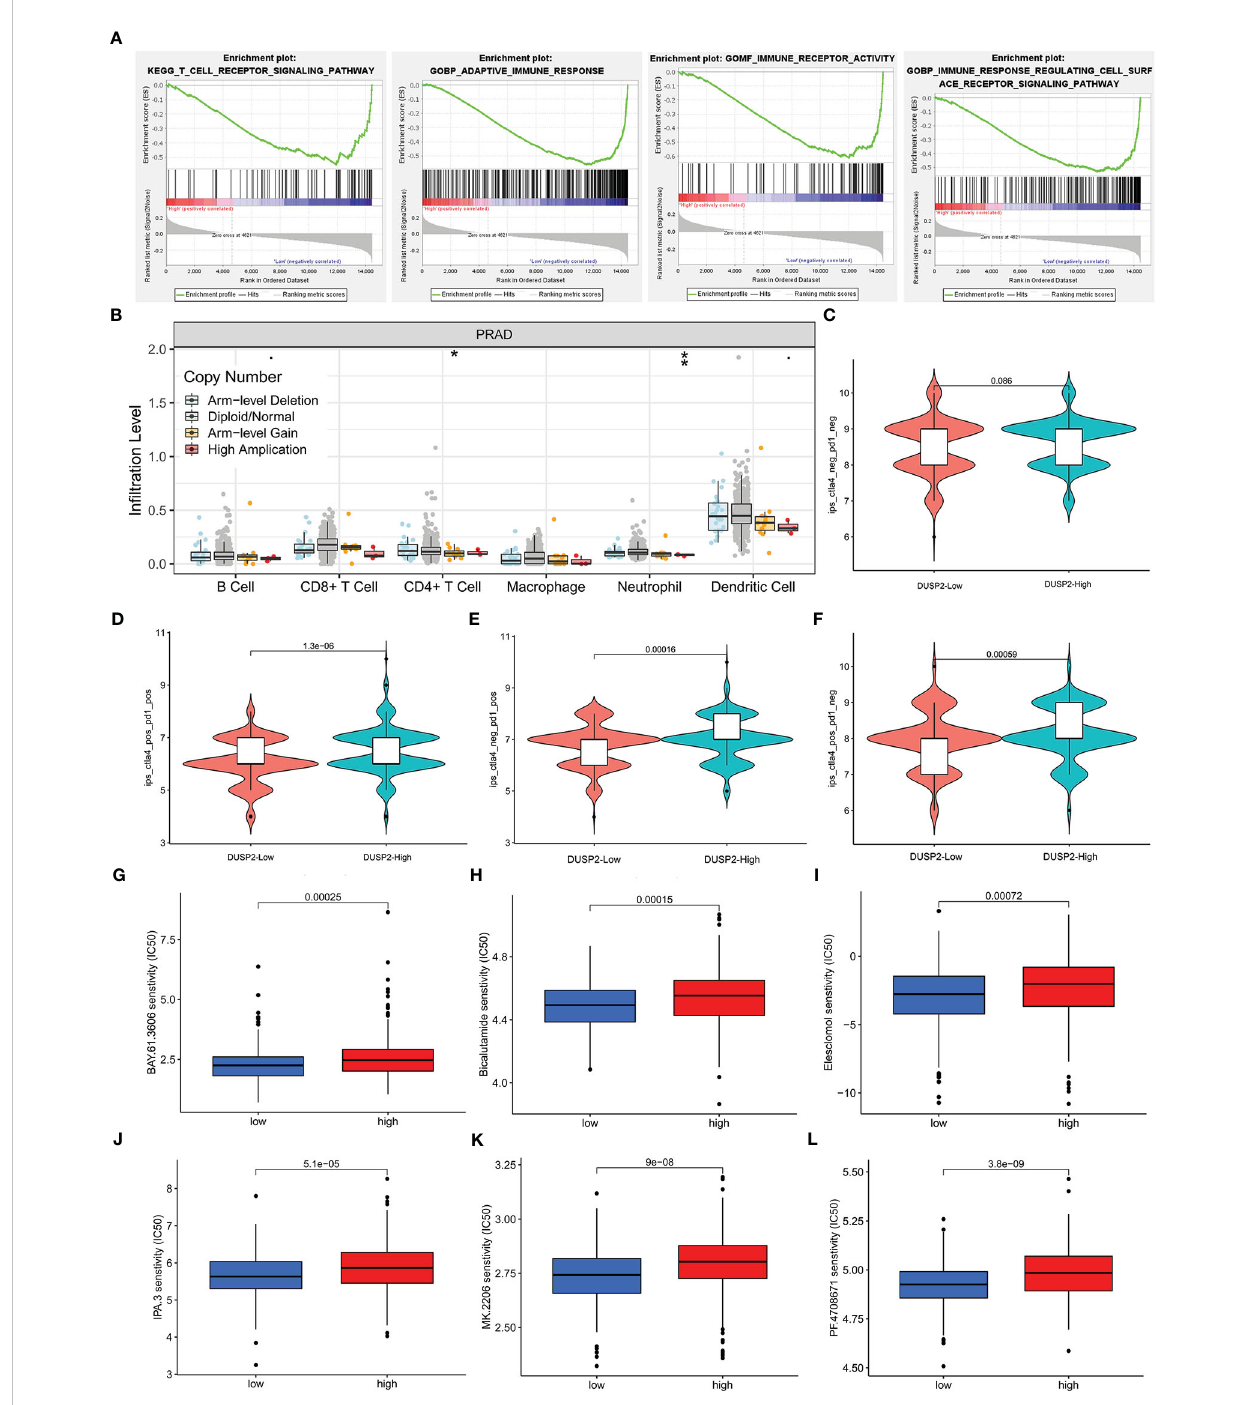
FIGURE 7 Immune in fi ltrate levels as well as immunotherapy or chemosensitivity analysis of DUSP2. (A) GSEA for DUSP2 with GSE60329. (B) Correlation of DUSP2 expression with immune in fi ltration level in PCa. (C – F) Low DUSP2 expression was negatively correlated with CTLA4 or/and PD1-positive levels. (G – L) DUSP2 acted as a potential predictor for chemosensitivity as low DUSP2 was related to a lower IC 50 for chemotherapeutics (low = low DUSP2 expression, high = high DUSP2 expression). *P <0.05, **P <